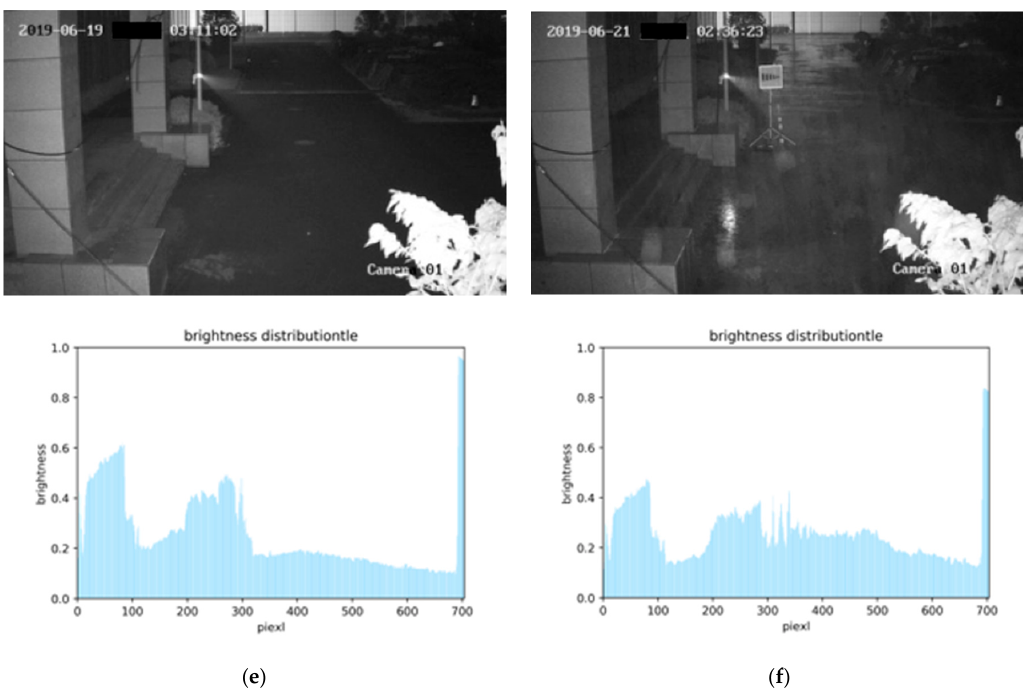
Figure 3. Horizontal brightness histograms of the images under different visibility conditions. ( a ) clear daytime; ( b ) foggy daytime; ( c ) clear evening; ( d ) foggy evening; ( e ) clear midnight; ( f ) foggy midnight.